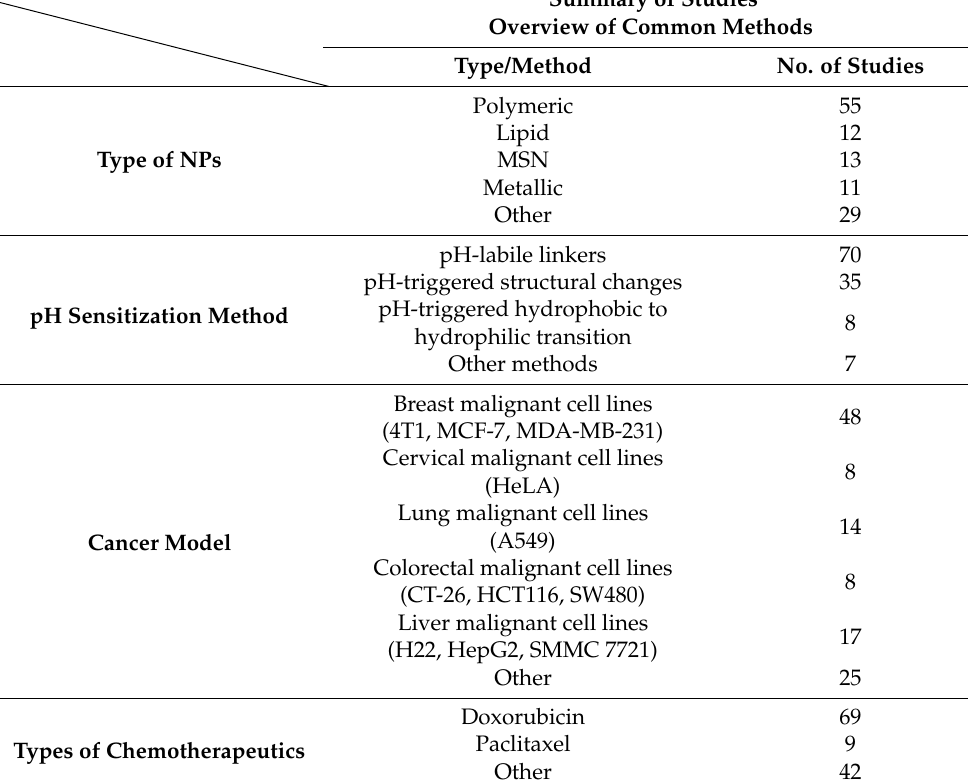
Figure 2. PRISMA flowchart. Table 2. Summary of methods used in studies.